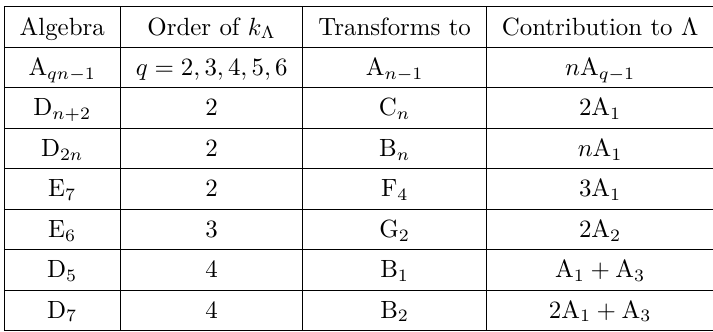
Table 2 . Freezing rules for the simple factors in the gauge groups according to the order of the corresponding entry in the element k Λ of the fundamental group associated to the freezing. In the first case, the resulting A n − 1 has roots of length 2 q